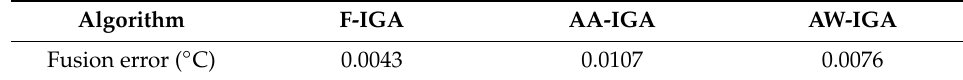
Table 1. Fusion error of three algorithms.